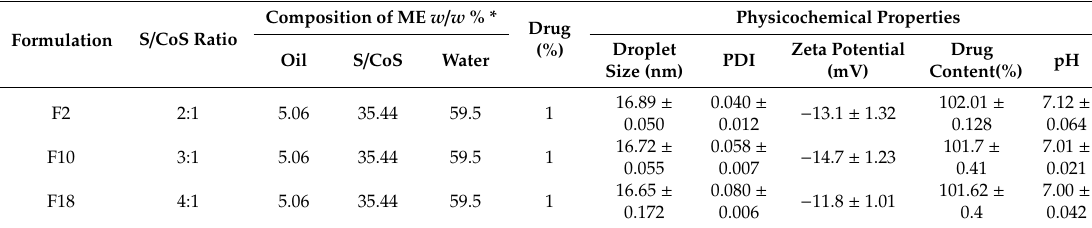
Table 3. Physicochemical properties of selected formulations (Mean ± SD, n =